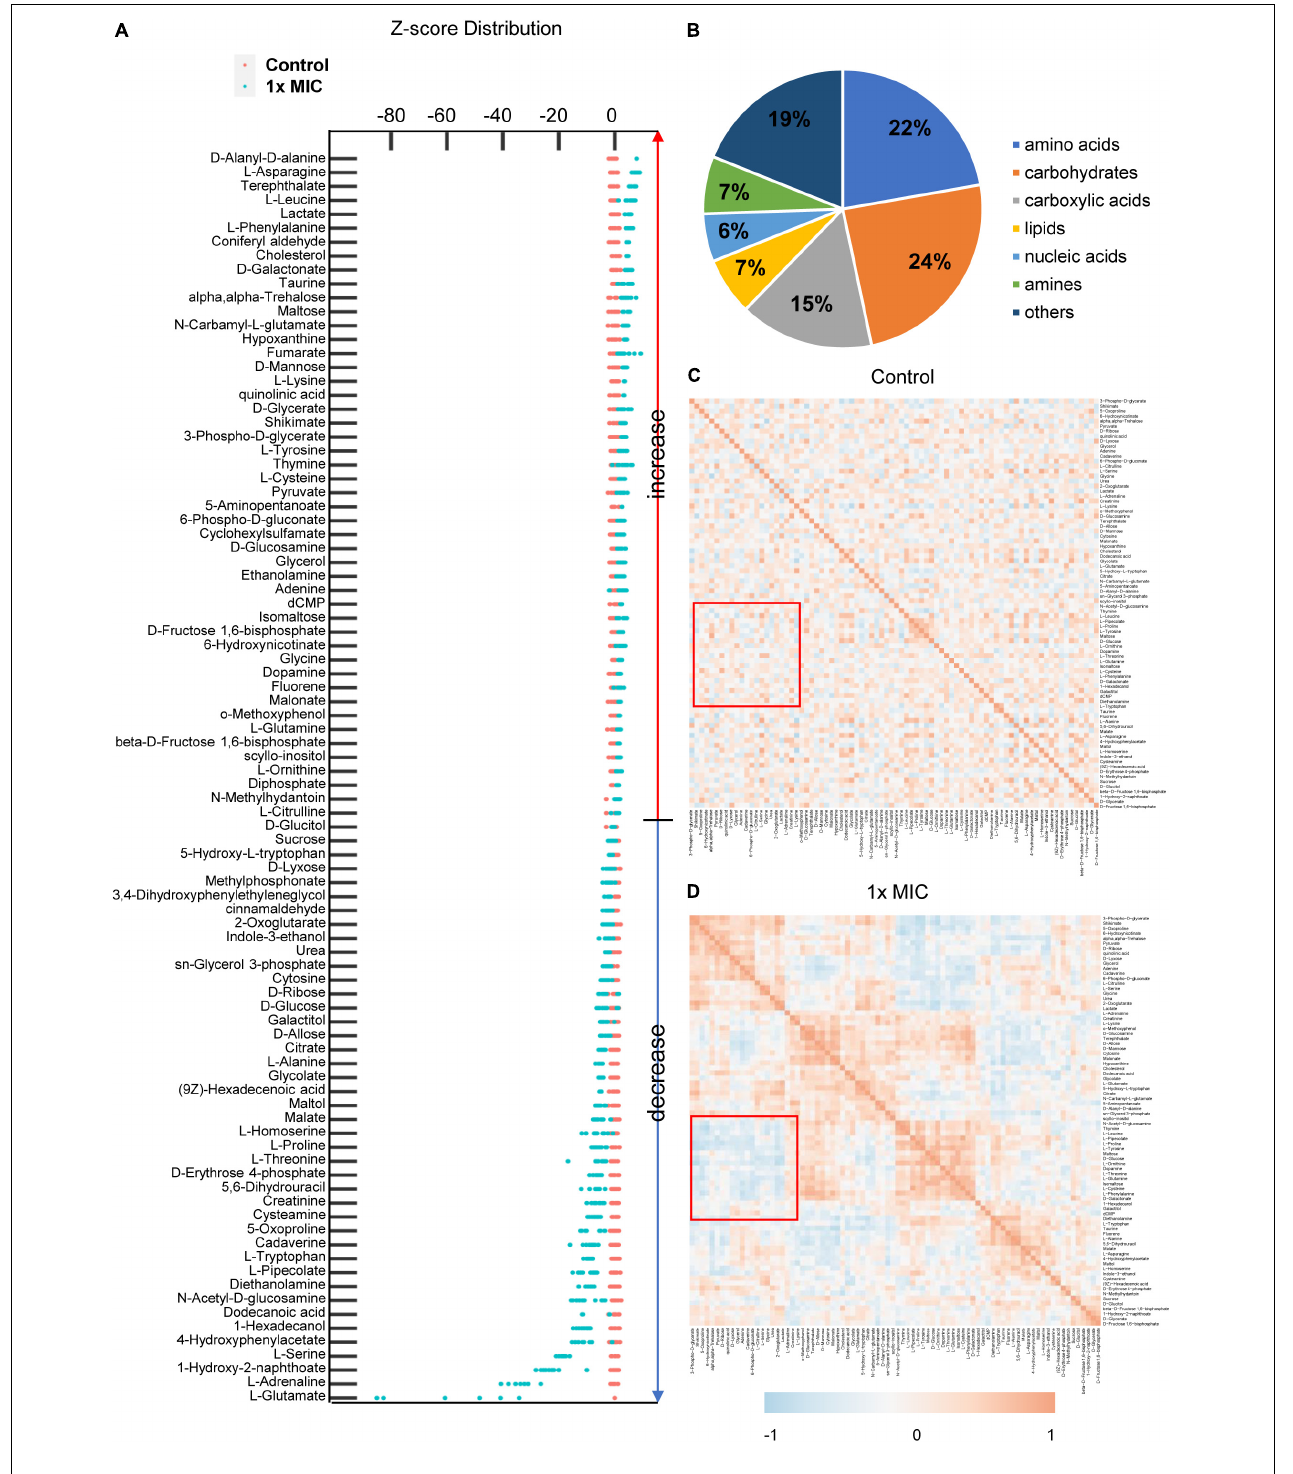
Frontiers in Microbiology |